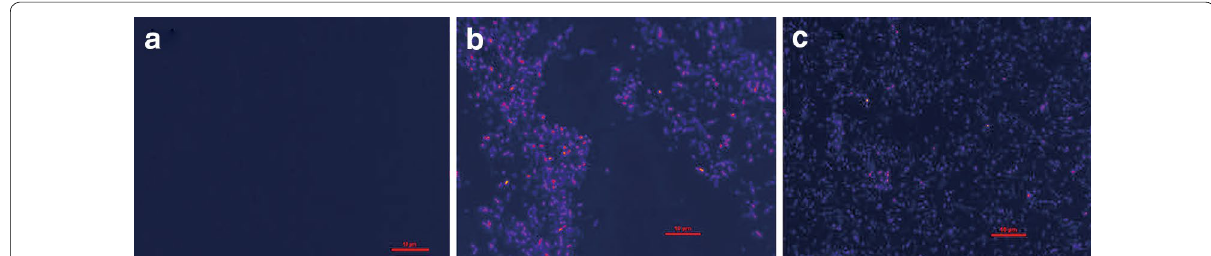
Fig. 6 Fluorescence microscopy visualization of Escherichia coli BL21 cells coexpressing a mN159, mC160, and SspB under blue light, b BNMnAS, BNMcAS, and SspB under blue light. c BNMnAS, BNMcAS, and SspB in the dark. Scale bar 10 μm